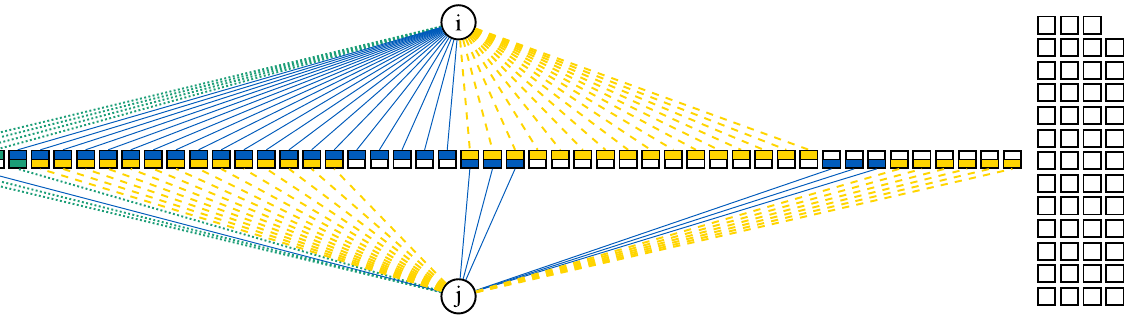
Figure 1. An illustration of a bipartite network focusing on two agents i and j represented as and their connections to 100 different events represented as . Each agent connects to events via three different types of links ( , , ). Additionally, the squares representing events are divided into two halves. The color of the top half indicates the type of connection node i has to this event, while the color of the lower half indicates the connection type of node j ( a 1 = , a 2 = , a 3 = ). Unfilled event squares indicate a lack of connection from nodes i and/or j .